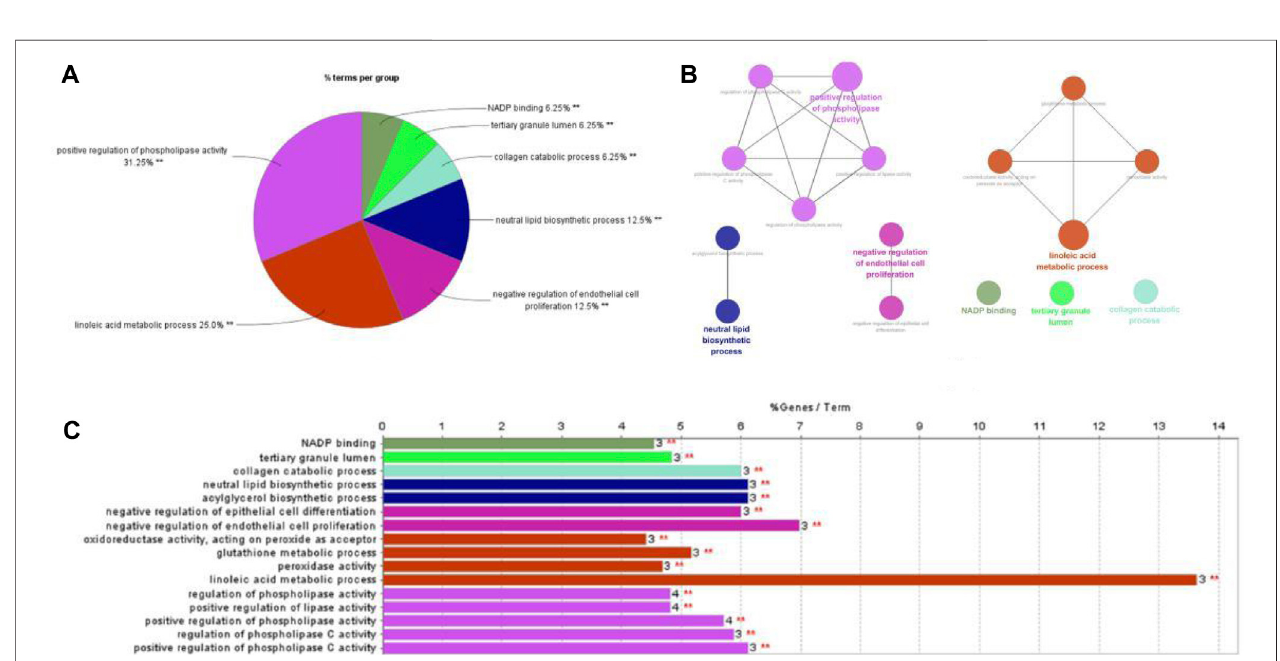
FIGURE 4 | GO analysis in trastuzumab treated with breast